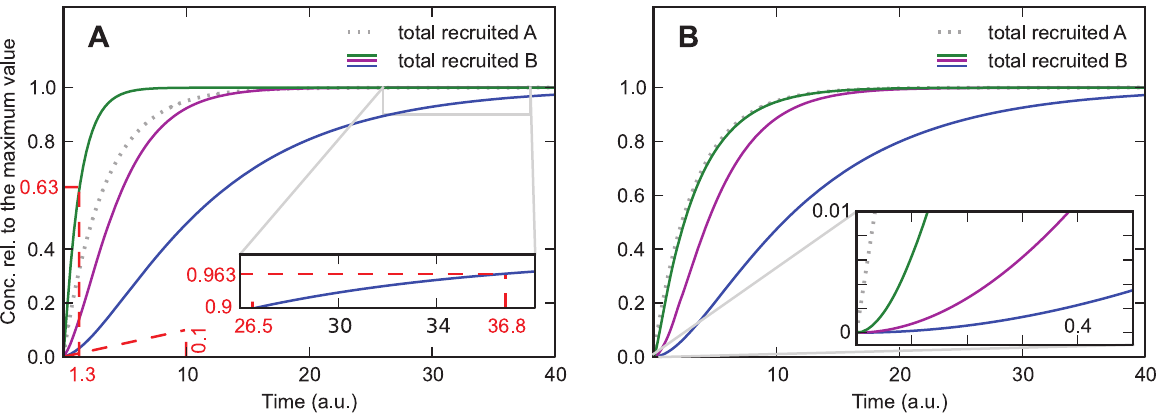
~ k (cid:3) ~ 0 : 3 and k (cid:3) ~ 0 : 1 , 0 : 5 , 5 from bottom S z A SB z A SA z B 1 & 0 : 77 for the steepest curve, and k (cid:3) & & 10 { 2 and S z B S z B 1 : 3